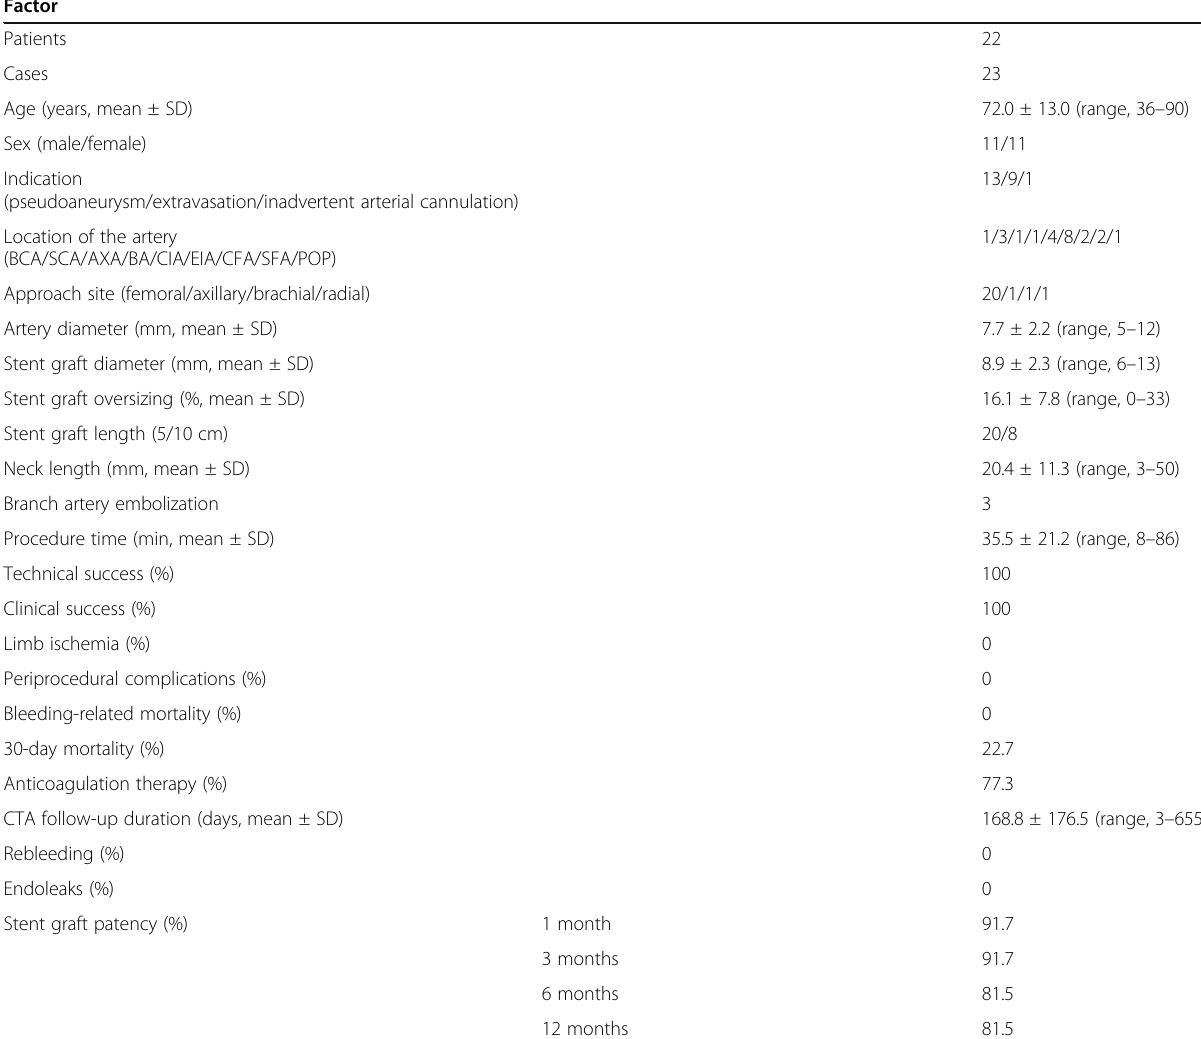
Table 1 Summary of